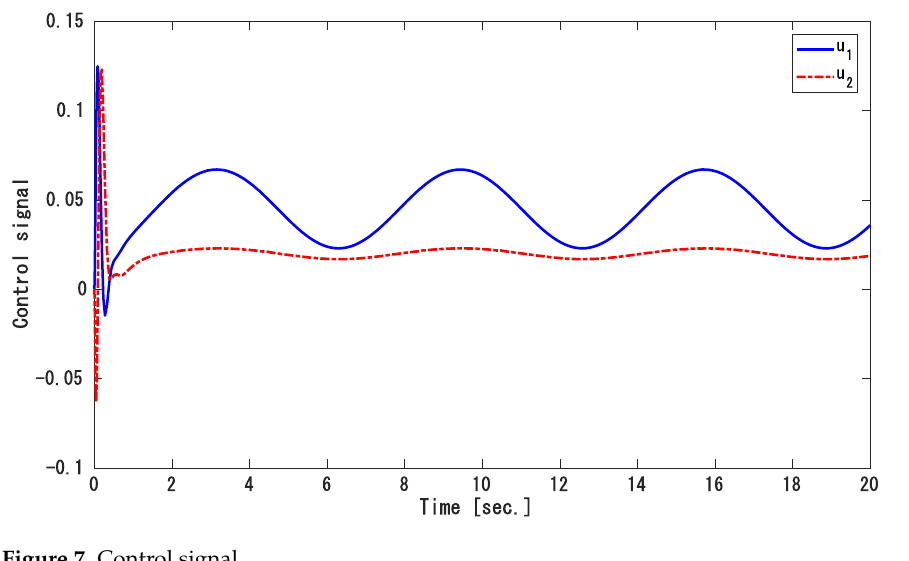
Figure 7. Control signal. Table 2. Setting time and maximum overshoot calculation of SOSMC and observer based SMC [31]. Kind of the